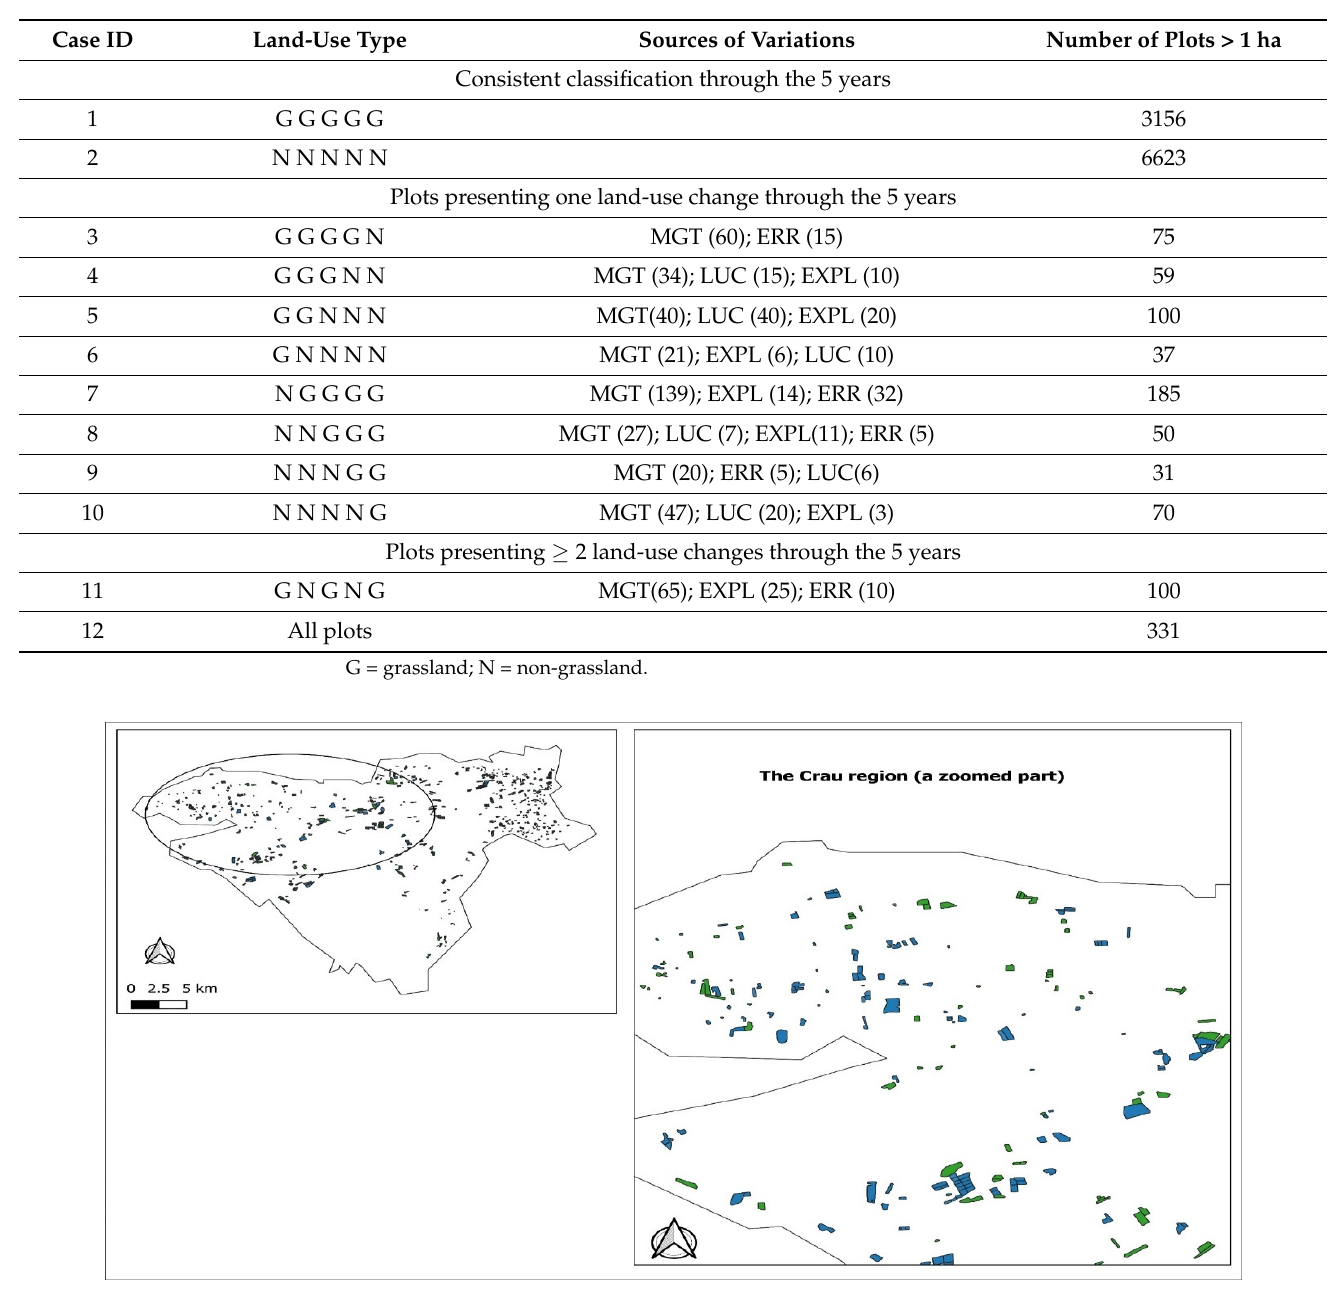
Figure 12. Landuse change map 2016–2020 showing changes from IPG to NIG (green) and NIG to IPG (blue) with a zoomed part.